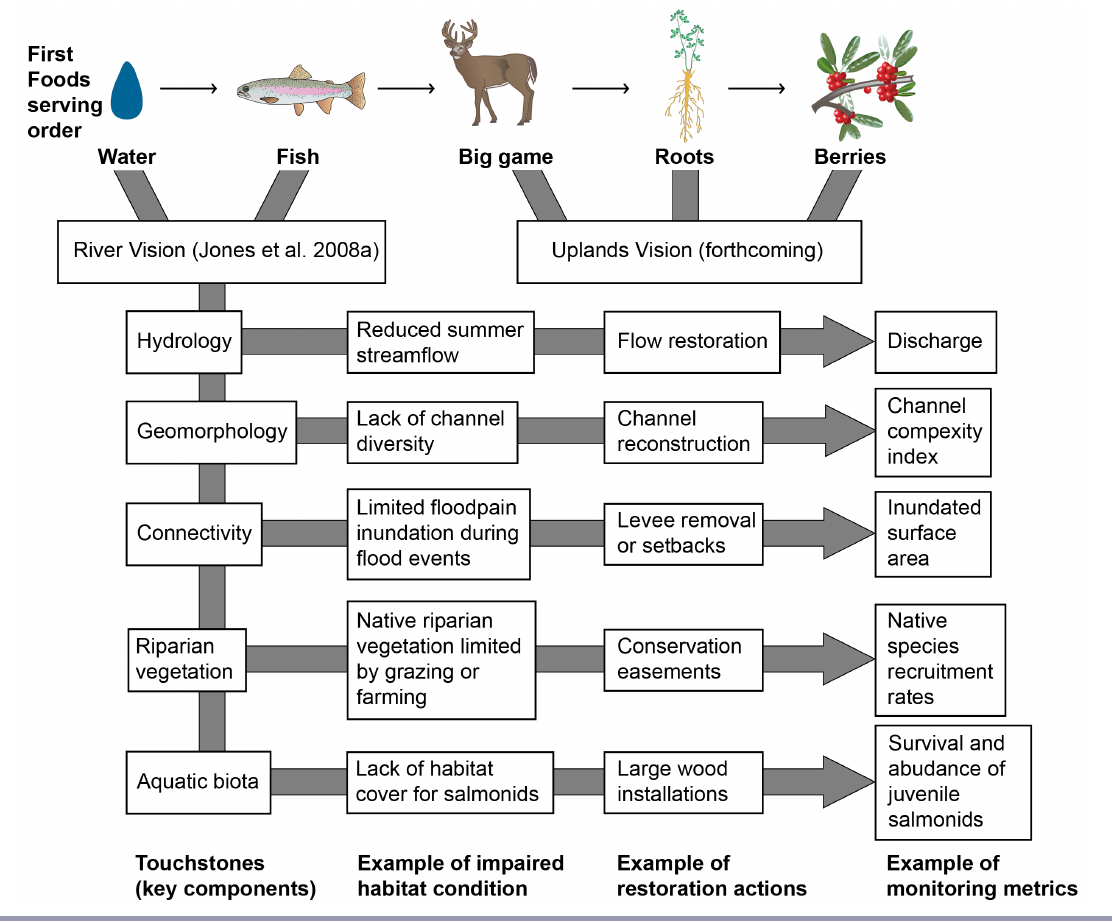
Fig. 11 . Linkages between First Foods, resource management visions, and management and habitat restoration actions. This figure focuses on the relationships between the River Vision, touchstones (or key components) of riverine ecosystems that support First Foods, and restoration actions and monitoring metrics related to addressing and measuring progress toward improving impaired habitat conditions. Images courtesy of the Integration and Application Network, University of Maryland Center for Environmental Science (http://ian.